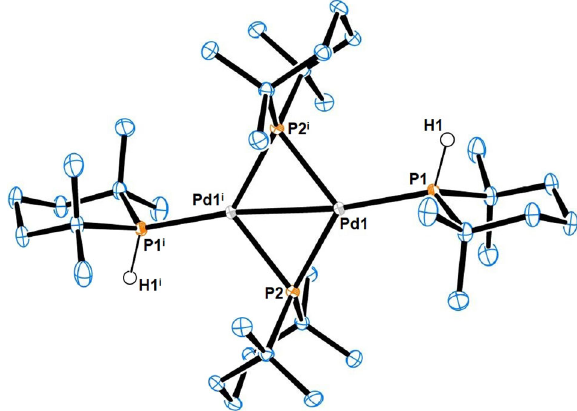
Fig. 6 Molecular structure of compound 15. Selected bond lengths (Å) and angles (°): Pd1-Pd1 i 2.6053(3), Pd1-P1 2.2686(3) Pd1-P2 2.3124(3), Pd1-P2